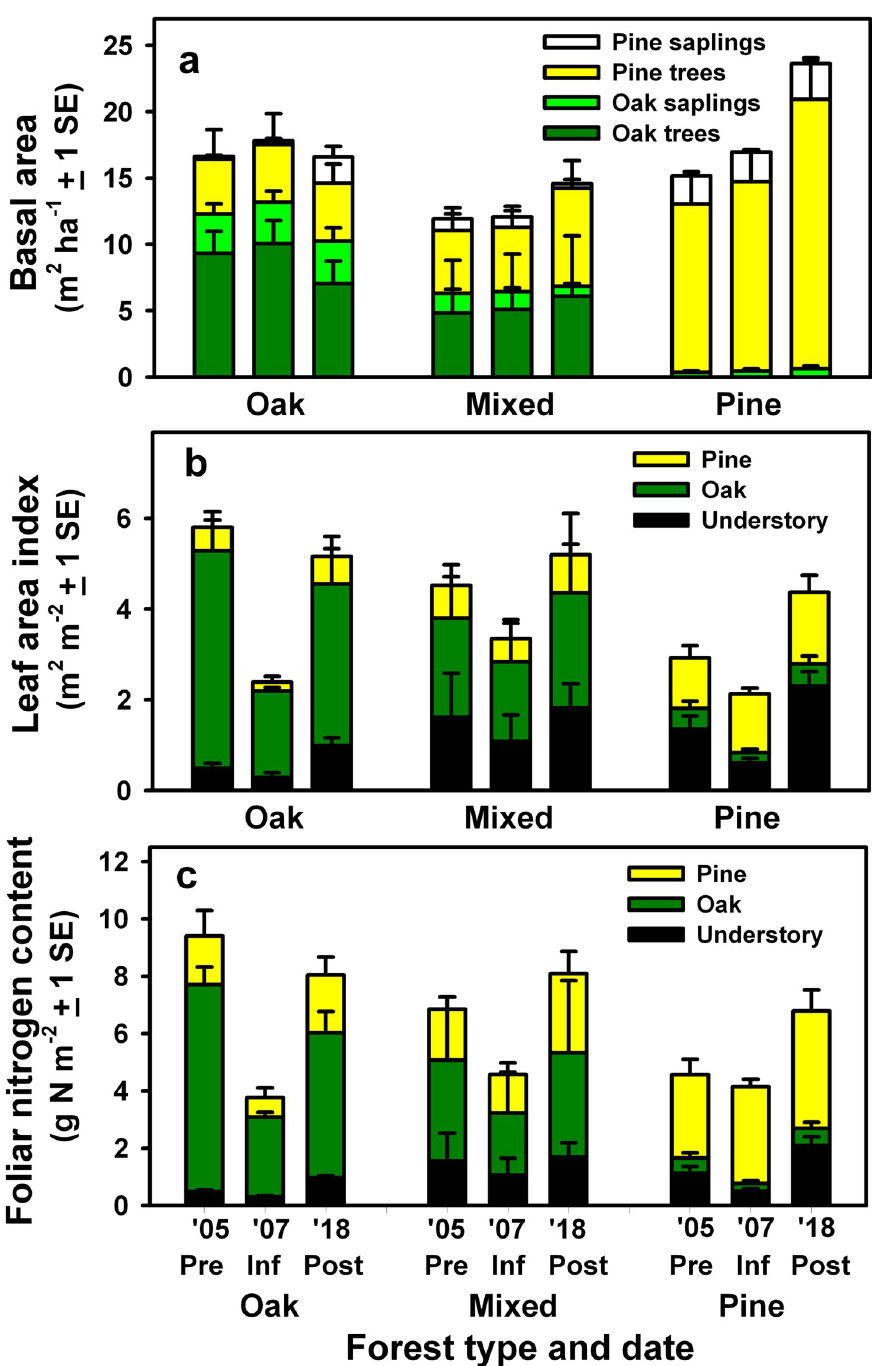
Fig 2. Effects of L . dispar infestations on forest composition and structure. (A) Basal area of pine and oak trees and saplings, (B) maximum leaf area of pines, oaks and understory vegetation during the growing season, and (C) maximum nitrogen content in foliage of pines, oaks and understory vegetation during the growing season prior to infestations in 2004 (Pre), during the year of peak defoliation in 2007 (Inf), and a decade following infestations in 2018 (Post) at the oak-, mixed and pine-dominated stands. Pine tree, sapling and seedling leaf area is expressed as one-sided LAI. Leaf area and foliar nitrogen content during infestations in 2007 reflect values after a second leaf-out of foliage in mid-July 2007 following complete defoliation of the oak stand, and partial defoliation of the mixed and pine stands.